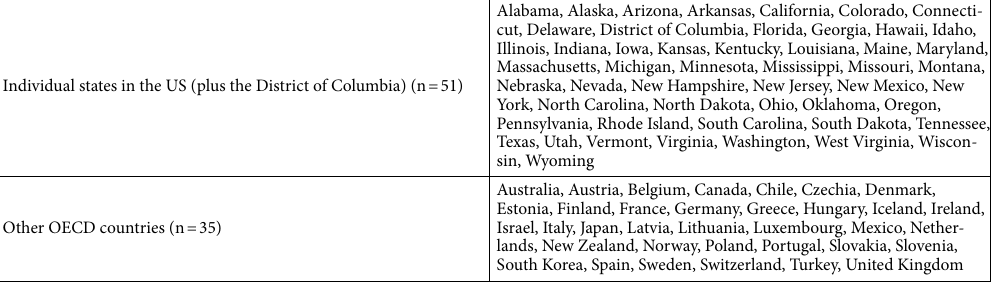
Individual states in the US (plus the District of Columbia) (n =